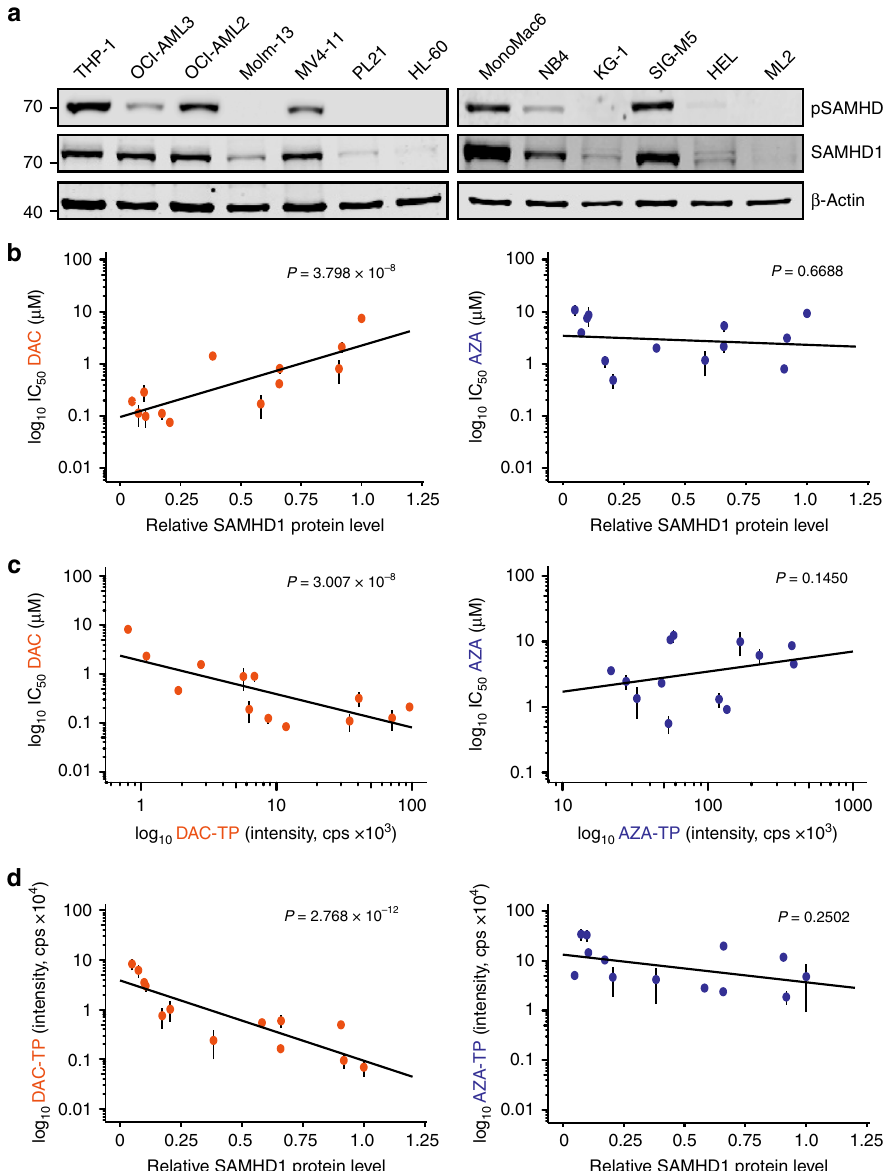
Fig. 2 SAMHD1 expression levels are inversely correlated with DAC ef fi cacy. a Representative immunoblots of SAMHD1 and phospho-SAMHD1 in the AML cell lines indicated. β -Actin served as a loading control. b – d Correlation analyses for DAC (orange cirles) and AZA (dark blue circles) in AML cell lines shown in ( a ) between ( b ) IC 50 values and cells ’ relative expression levels of SAMHD1, or c IC 50 values and their corresponding triphosphate levels determined by LC – MS/MS, or d triphosphate levels and relative expression levels of SAMHD1. Expression levels were normalized to β -actin and are shown as arbitrary units (a.u.); the relative expression of each protein in THP-1 cells was set to 1. For ( b – d ), closed circles and error bars represent means ± s.d. of three independent experiments, each performed in three technical replicates. Data were analyzed using a generalized log-logistic model. P -values for goodness-of- fi t were computed using the likelihood-ratio (chi-squared) topoisomerase I inhibitors topotecan, and the alkylating agents lomustine and melphalan (Supplementary Fig. 7).